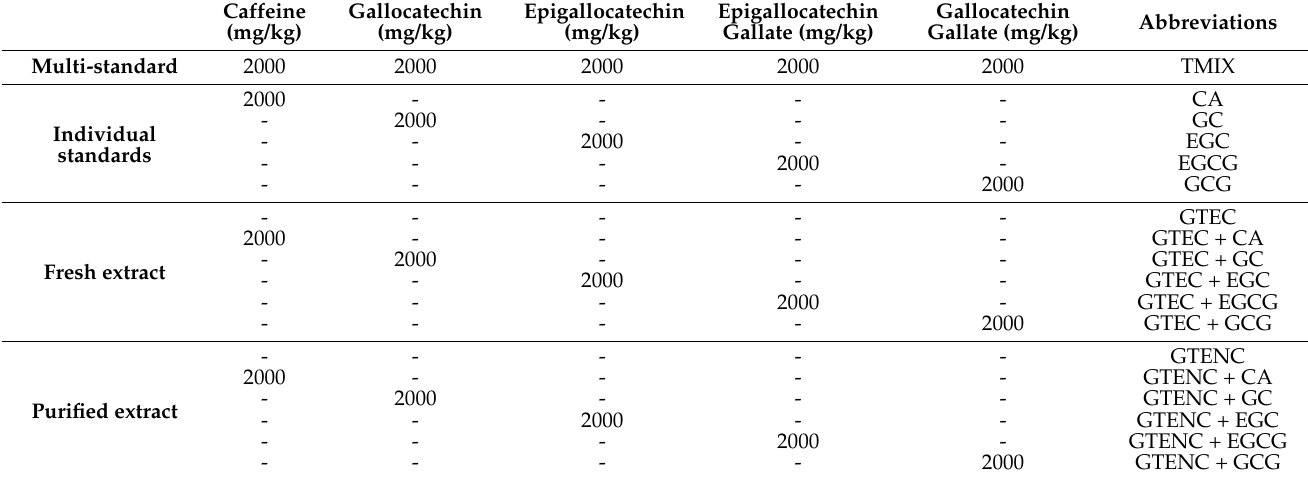
Table 3. Combinations of individual phenolic compounds with both fresh and purified